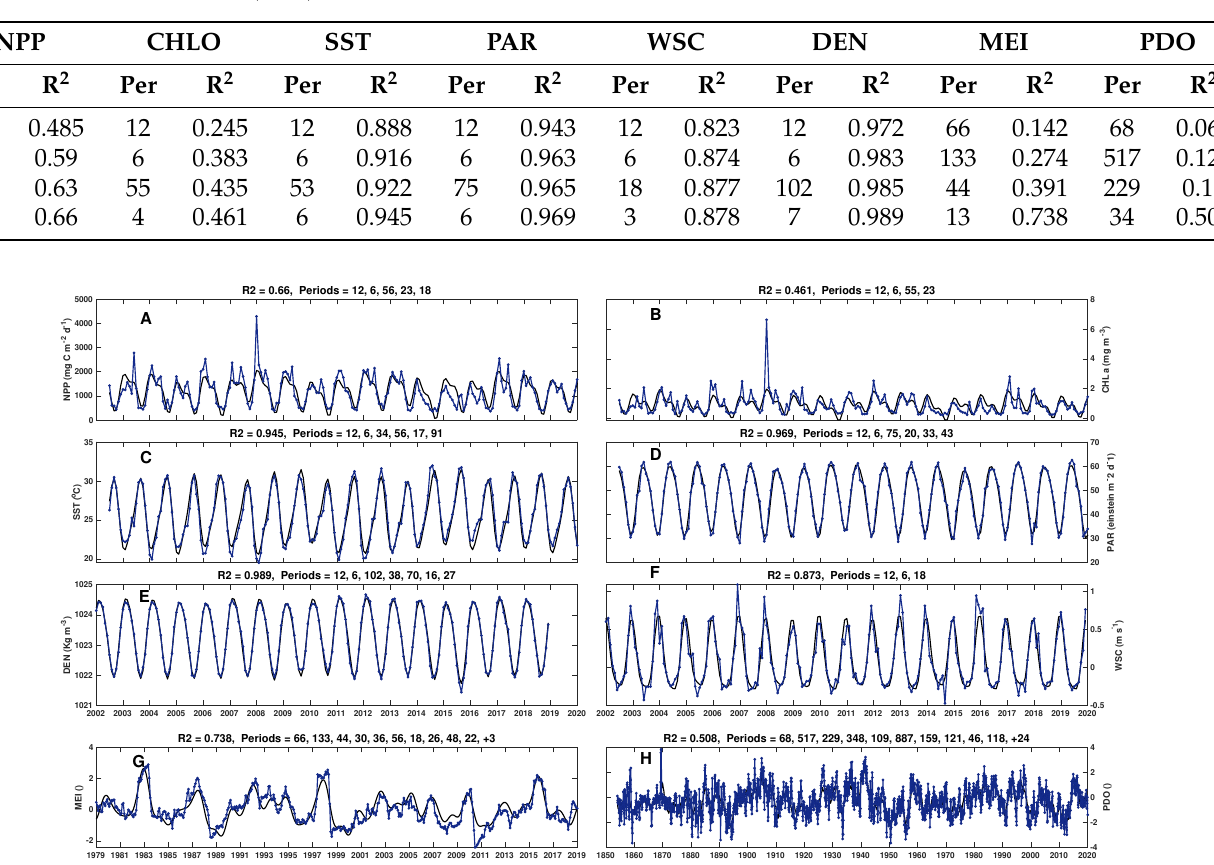
Table 2. Summary of the periods for the first three harmonics for each variable analyzed by the cyclical descent technique. The R 2 values is the accumulated correlation coefficient for each variable per period. The numbers in per indicate the total number of significant harmonics for each variable and the final R 2 considering these harmonics. Abbreviations: Net primary production (NPP), chlorophyll (CHLO), sea surface temperature (SST), photosynthetically available radiation (PAR), wind stress curl (WSC), relative surface density (DEN), multivariate El Niño/Southern Oscillation Index (MEI), Pacific decadal oscillation (PDO).